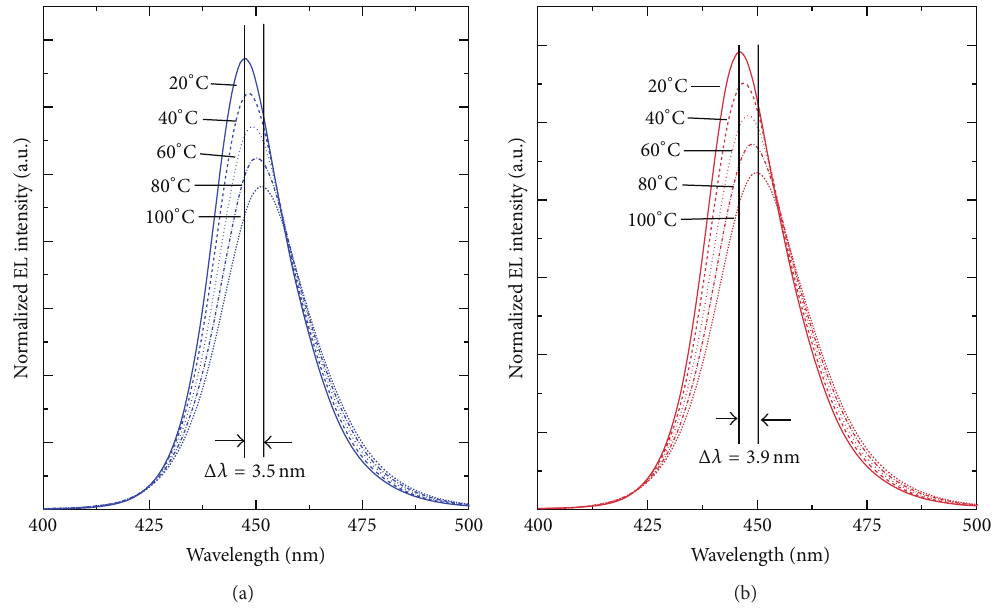
Figure 6: Normalized EL spectra as a function of the heat sink temperature for the (a) DLC-FCLED and (b) non-DLC-FCLED with an injection current of 1000 mA.